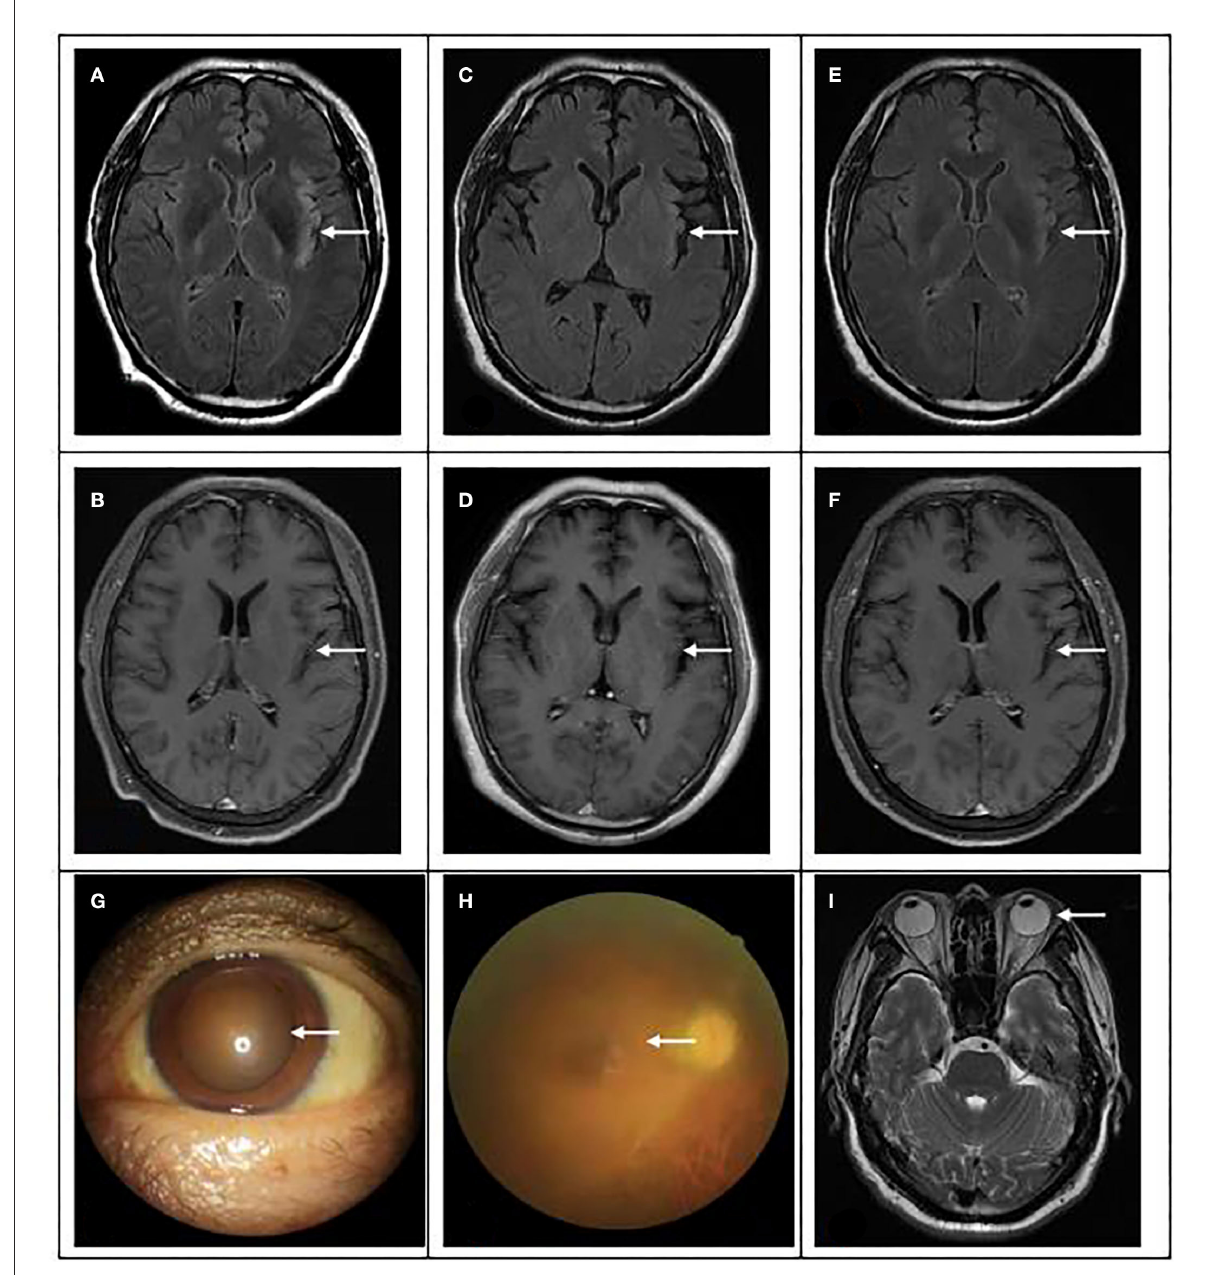
FIGURE2 Brain magnetic resonance and eye examination results. (A,B) On 15 April, brain magnetic resonance showed multiple spots and bands of abnormal signals in the left insular and temporal cortex, high signal in T2WI and T2flair, and equal and low signal in T1flair. (C,D) On 24 April, MRI showed abnormal signal and meningeal changes in the left frontal temporal insula. (E,F) On 04 June, magnetic resonance imaging showed that the range of inflammatory lesions was slightly smaller than before. (G) The pupil of the patient was significantly enlarged, with a diameter of 5 × 5mm. (H) Fundus lesions: vitreous cavity is turbid, the optic disc boundary is indistinctly seen, and white line changes can be seen in the peripheral momentum. (I) : No abnormality was found in eyeball magnetic resonance.